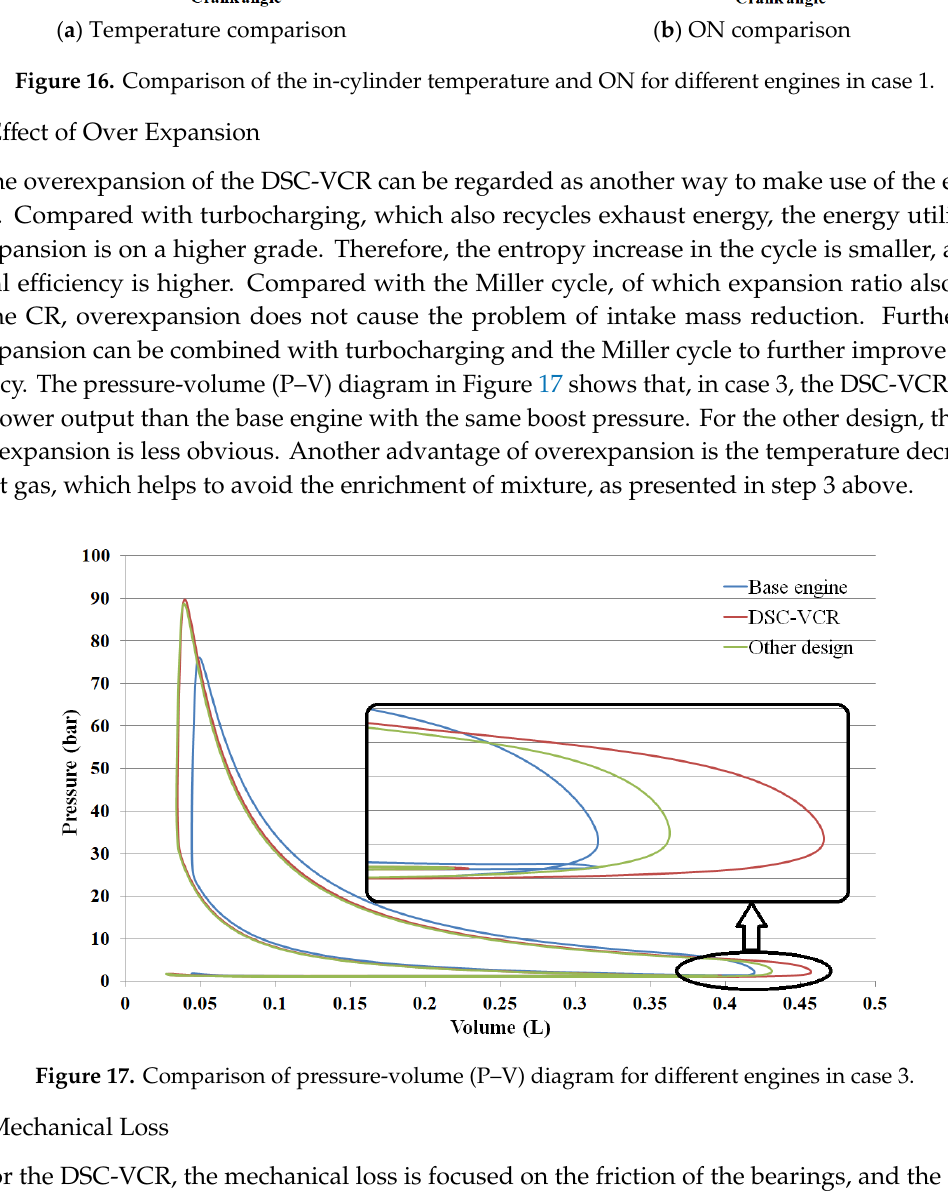
Figure 17. Comparison of pressure-volume (P – V) diagram for different engines in case 3.